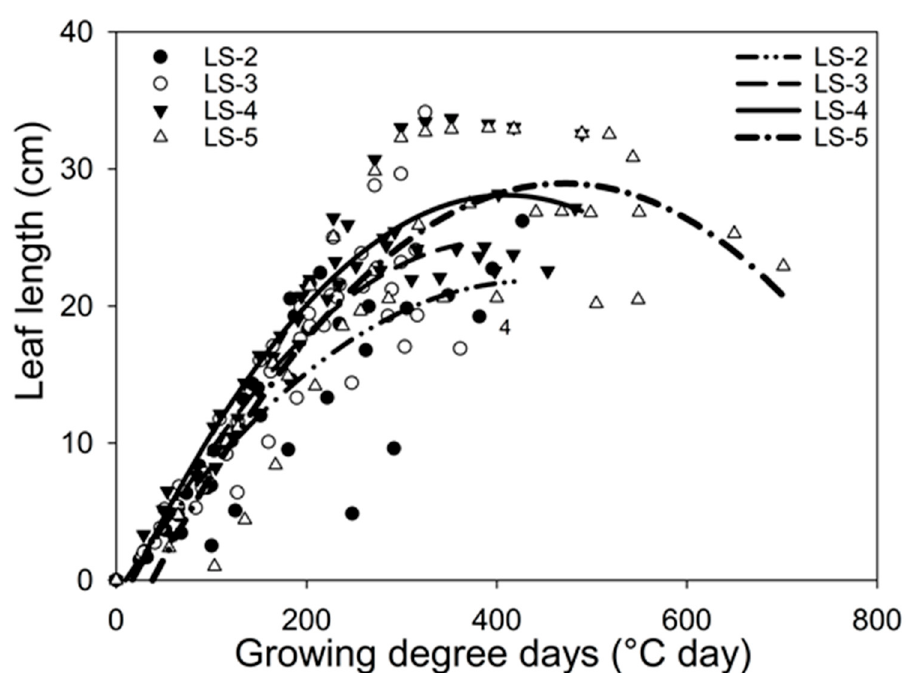
Figure 3. Bromus valdivianus growth rate of the first fully expanded lamina (Leaf 3) from each defoliation frequency, leaf stage 2 (filled circle; dotted with dashed line), leaf stage 3 (empty circle; dashed line), leaf stage 4 (filled triangle; continuous line) and leaf stage 5 (empty triangle; dotted line). The equations are for LS-2) y = − 0.0001x 2 + 0.1045x − 1.0023 (R 2 = 0.71); LS-3) y = − 0.0002x 2 + 0.135x − 2.3488 (R 2 = 0.83); LS-4) y = − 0.0002x 2 + 0.1489x − 2.4398 (R 2 = 0.87); LS − 5) y = − 0.0002x 2 + 0.1456x − 5.3445 (R 2 = 0.80). Table 1. Plant parameters at the final harvest and the accumulation over several defoliations intervals under different defoliation frequencies for B. valdivianus defoliated by leaf stage development (LS).